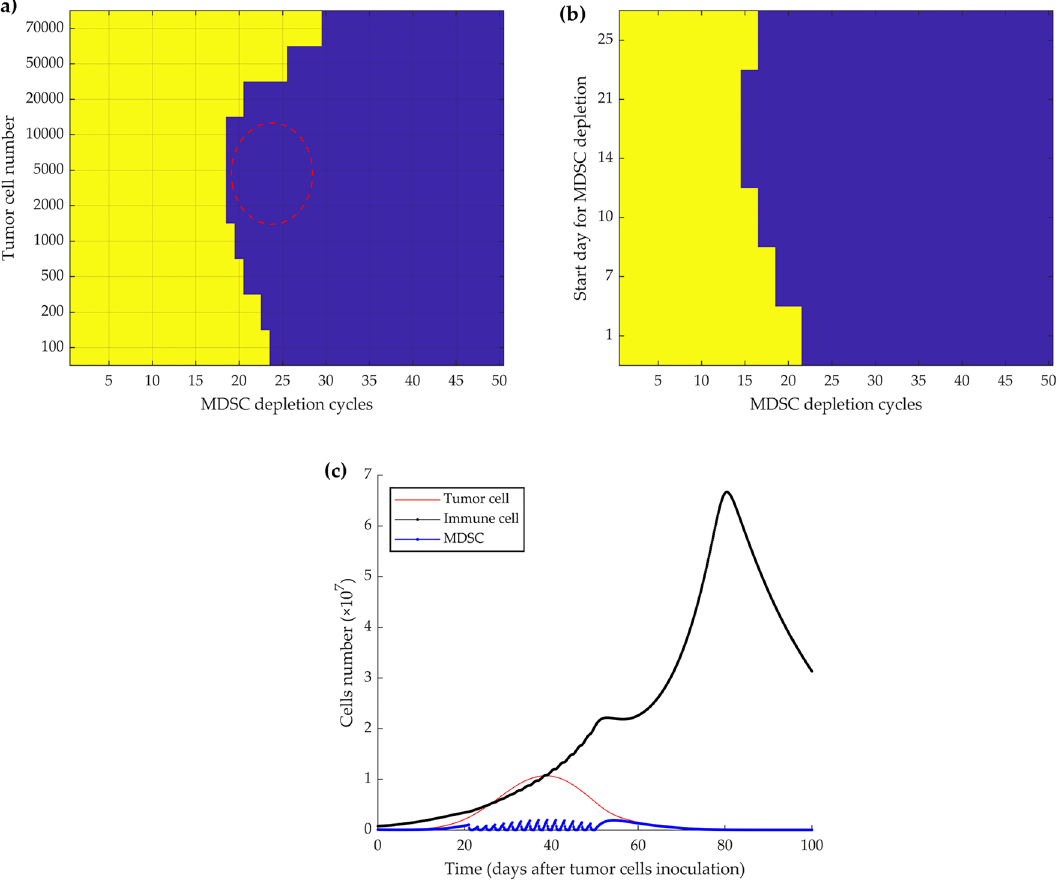
Figure 5. Simulation of an effective schedule of MDSC-depletion in mice bearing proliferative tumor cells. The necessary repetition of depletion every 2 days starting from day 7, is shown based on different initial tumor sizes ( a ) and the depletion starting point. Mice were injected with 5000 tumor cells ( b ). Color-coded events: blue, dormancy; yellow, tumor growth. Depletion of MDSC every 48 h from day 21 for 15 cycles in mice initially injected with 5000 tumor cells results in tumor growth control and permanent dormancy ( c